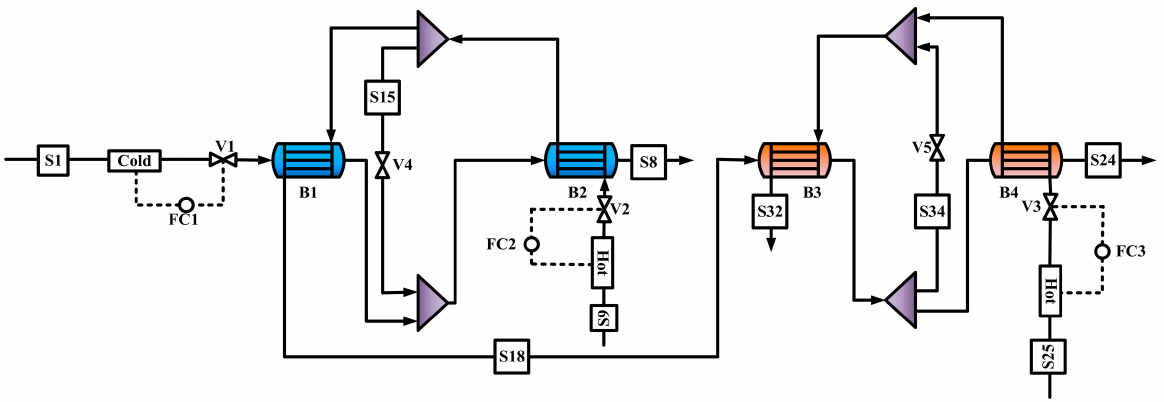
Figure 4. Heat exchangers dynamics simulation.